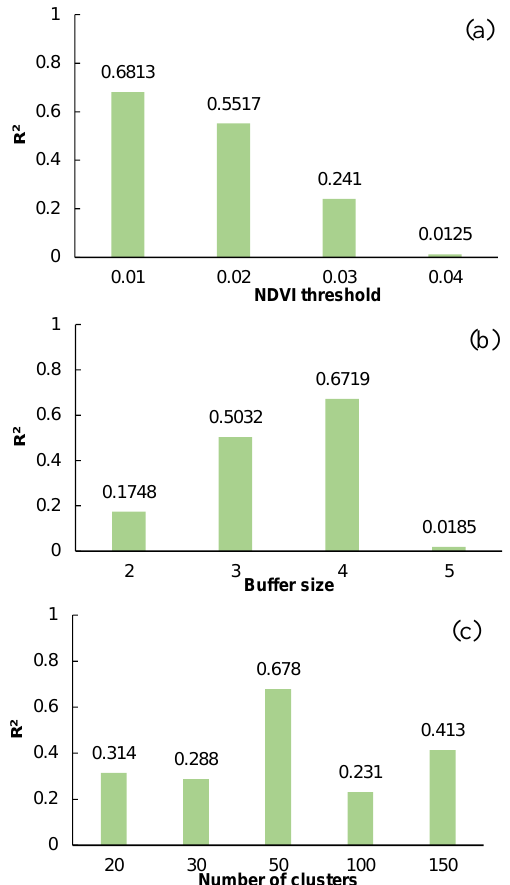
Figure 3. The relationship of key parameters with the coefficient of determination, ( a ) NDVI threshold, ( b ) Buffer size, ( c ) Number of clusters. According to the effect of BiodivMapR parameters on the accuracy, we estimated alpha diversity for 1990, 2000, 2010, and 2020 with the parameter values at the highest coefficient of determination. The highest value of correlation coefficients of alpha diversity and the Shannon – Wiener index was 0.6827 (Table 2). Table 2. Summary of linear regressions for Shannon – Wiener index with spectral diversity.